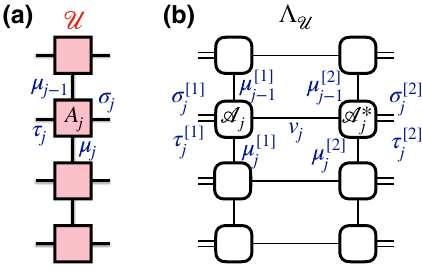
FIG. 3. Tensor network representations of a quantum channel U . (a) The superoperator U in its MPO form. (b) The Choi matrix (cid:6) U parameterized by a LPDO.